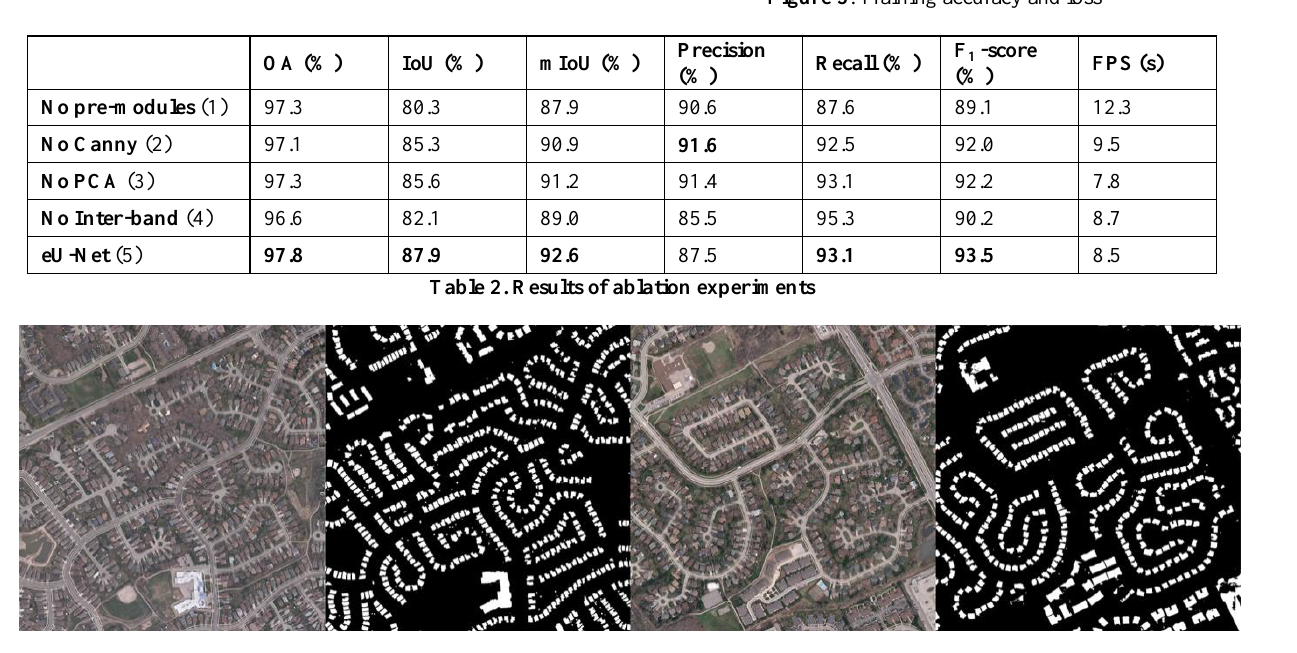
Figure 6 . Examples of eU-Net study mosaic results